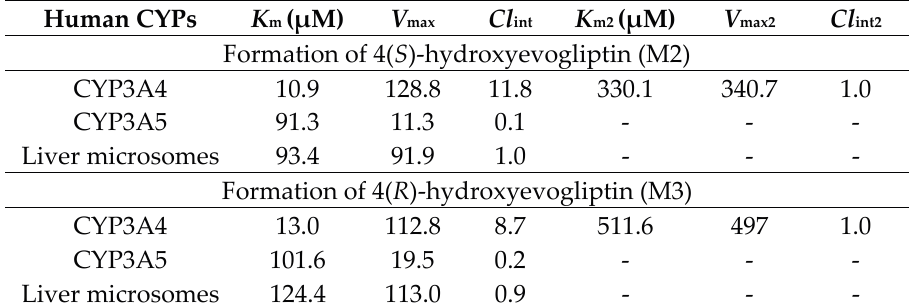
Figure 3. Enzyme kinetics for the formation of 4( S )-hydroxyevogliptin (M2,  ) and 4( R )-hydroxyevogliptin (M3,  ) from evogliptin in ( A ) human liver microsomes; ( B ) human cDNA-expressed CYP3A4; and ( C ) by human cDNA-expressed CYP3A5. Table 3. Enzyme kinetic parameters for the metabolism of evogliptin to 4( S )-hydroxyevogliptin (M2) and 4( R )-hydroxyevogliptin (M3) in human liver microsomes and human cDNA-expressed CYP